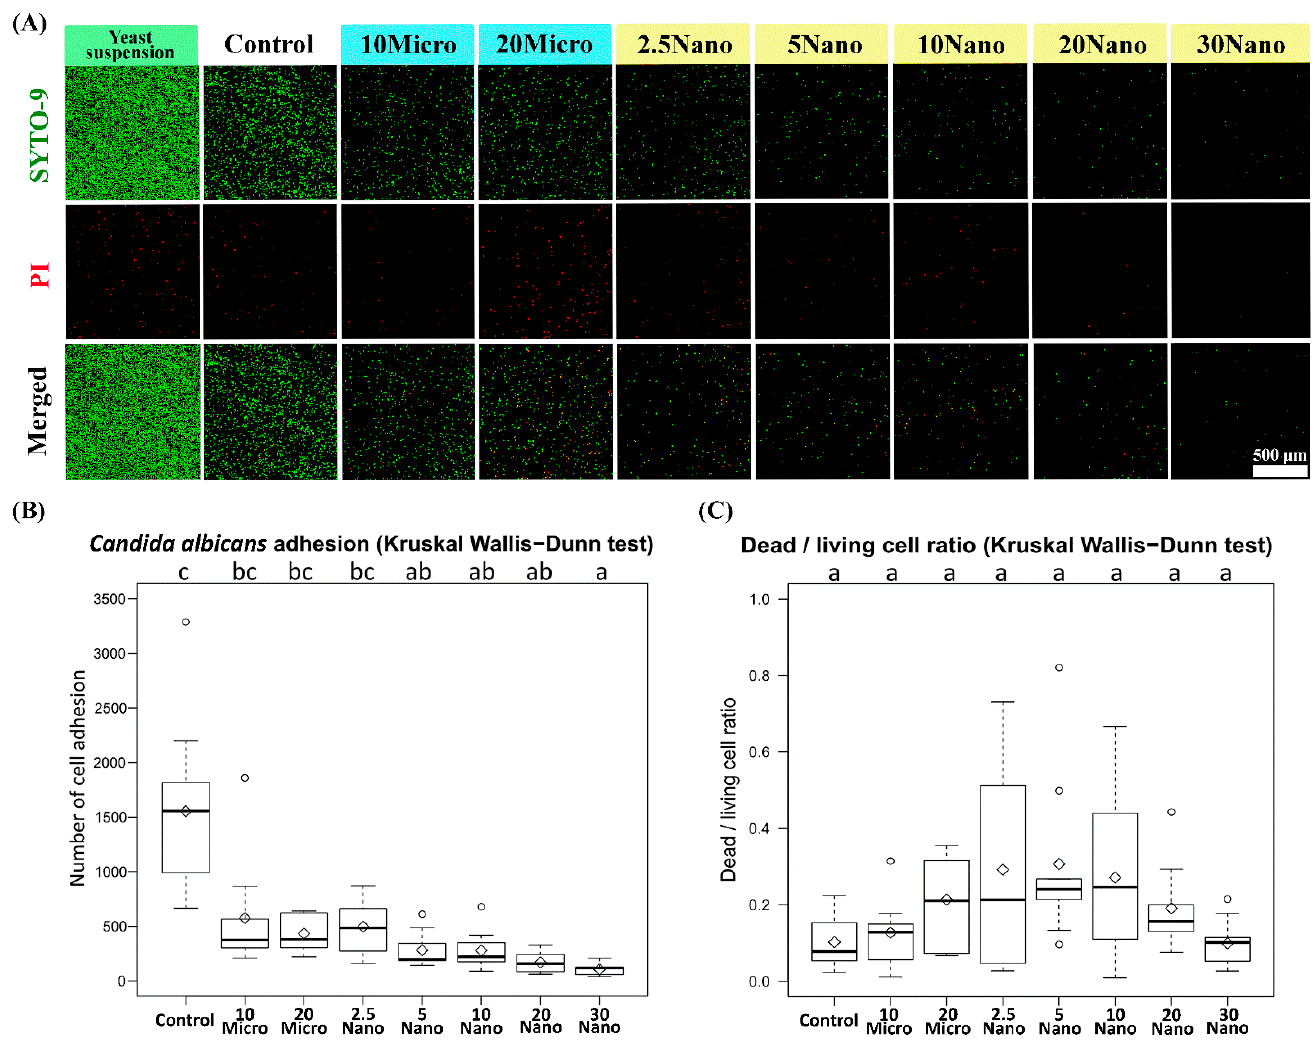
Figure 6. ( A ) Confocal laser scanning fluorescence micrographs showing Candida albicans cell adhesion on tissue conditioner specimens. The red-colored cells were stained using propidium iodide (PI) and considered dead. ( B ) Number of cell adhesion and ( C ) dead/living cell ratio on the specimens. The number of living cells (colored green) was calculated as the total cell number minus the dead cell number.